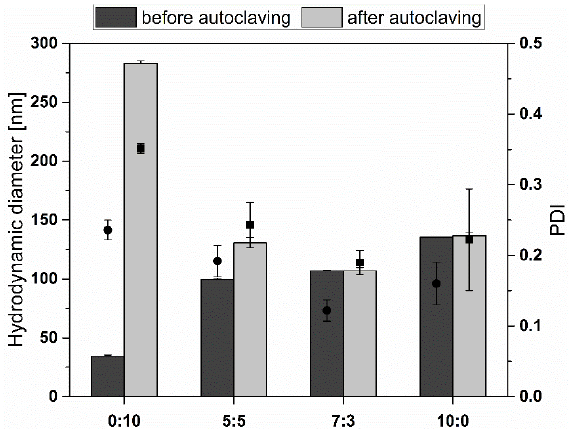
Figure 3. The hydrodynamic diameter and polydispersity index (PDI) of liposomes composed of tetraether lipids (TEL) and Phospholipon 100H (Ph) in different molar ratios (0:10, 5:5, 7:3, 10:0; TEL:Ph) before (filled circle) and after (filled square) autoclaving.